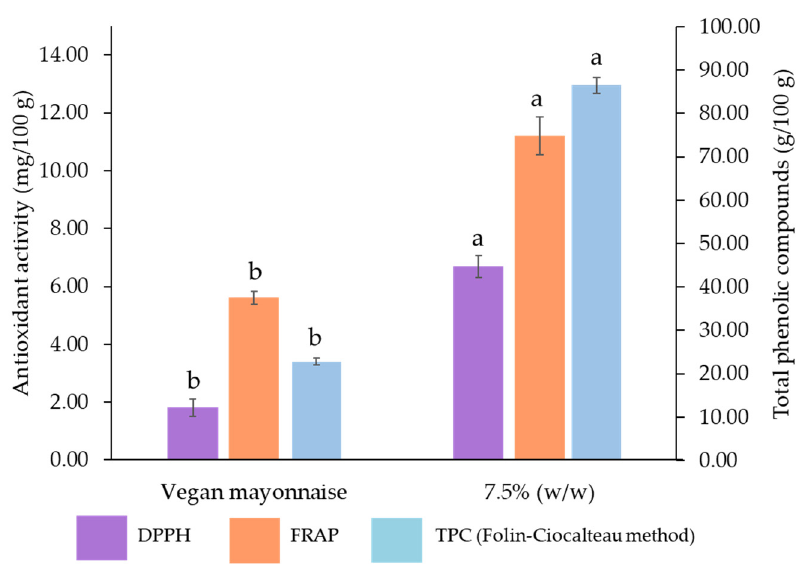
Figure 17. Total phenolic compounds (TPC) and antioxidant capacity (FRAP and DPPH methods) of standard and 7.5% ( w / w ) miso emulsions, expressed as mg of gallic acid equivalents per 100 g of emulsion. Different letters indicate significantly different results ( p < 0.05) according to t -test.